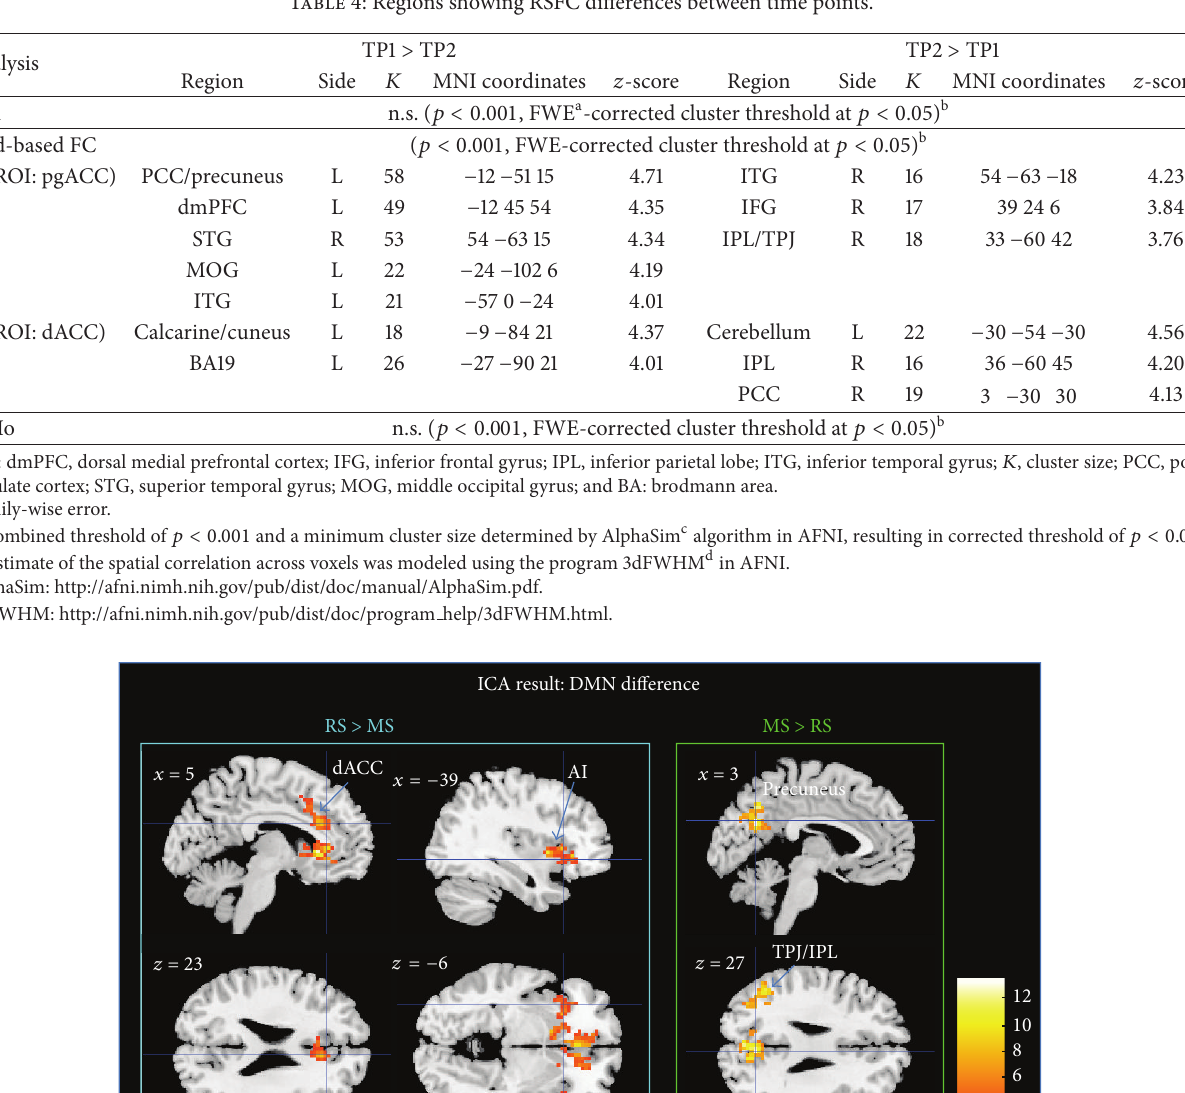
Table 4: Regions showing RSFC differences between time points.